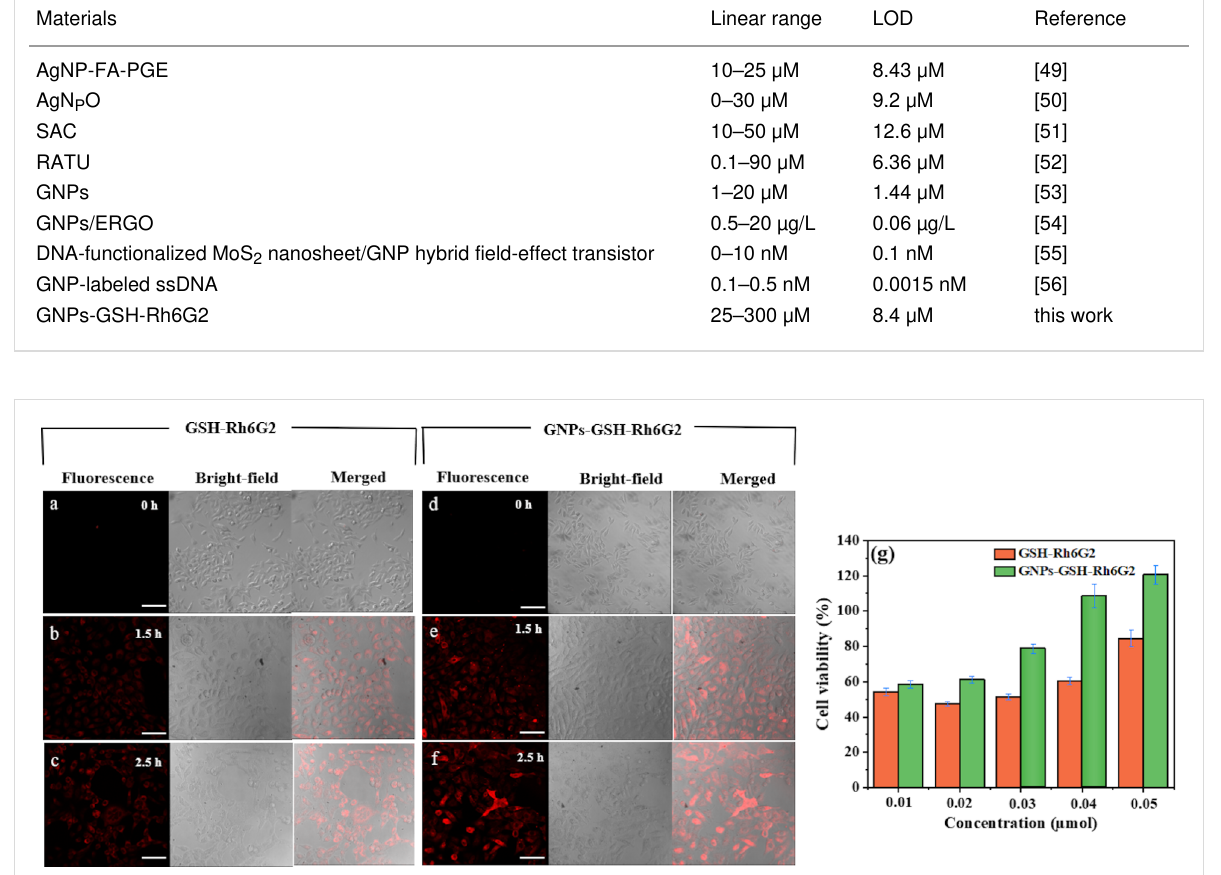
Figure 6: Real-time fluorescence imaging of HeLa cells treated with (a–c) GSH-Rh6G2 and (d–f) GNPs-GSH-Rh6G2 together with 100 µL with Hg 2+ after different incubation times (0, 1.5 and 2.5 h). The scale bars are 100 µm. From left to right, the images represent fluorescence, bright-field, and merged-channel fluorescence imaging. (g) Evaluation of cytotoxicity on HeLa cells of GSH-Rh6G2 and GNPs-GSH-Rh6G2 at different concentrations (0.01, 0.02, 0.03, 0.04, and 0.05 µmol) after incubation for 24